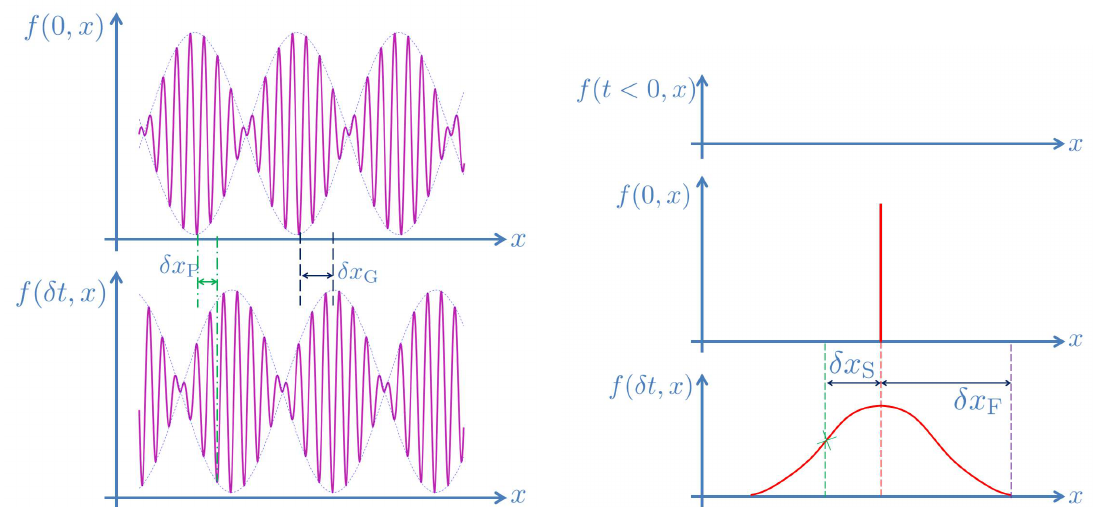
Figure 5: Difference between phase, group, signal and front velocities. At 𝑡 = 𝛿𝑡 , the phase and group velocities are represented on the left and given respectively by 𝑣 phase = 𝛿𝑥 𝑃 /𝛿𝑡 and 𝑣 group = 𝛿𝑥 𝐺 /𝛿𝑡 (in the limit 𝛿𝑡 → 0.) The signal and front velocity represented on the right are given by 𝑣 signal = 𝛿𝑥 𝑆 /𝛿𝑡 (where 𝛿𝑥 𝑆 is the point where at least half the intensity of the original signal is reached.) The front velocity is given by 𝑣 front = 𝛿𝑥 𝐹 /𝛿𝑡